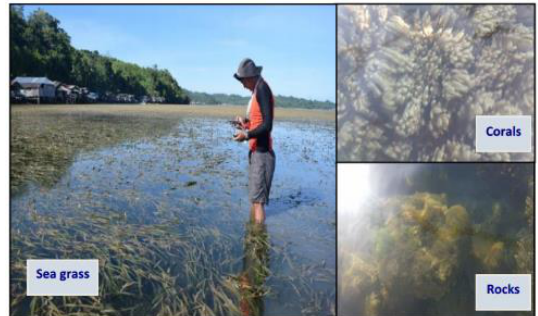
Figure 10. Benthic habitat validated in the coastal area of Cambatong, Hinatuan, Surigao Del Sur